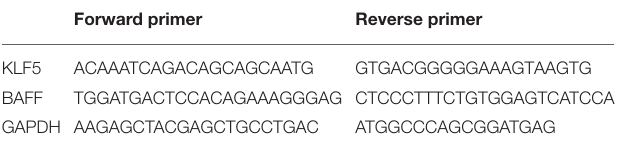
TABLE 2 | Primer sequences for real-time